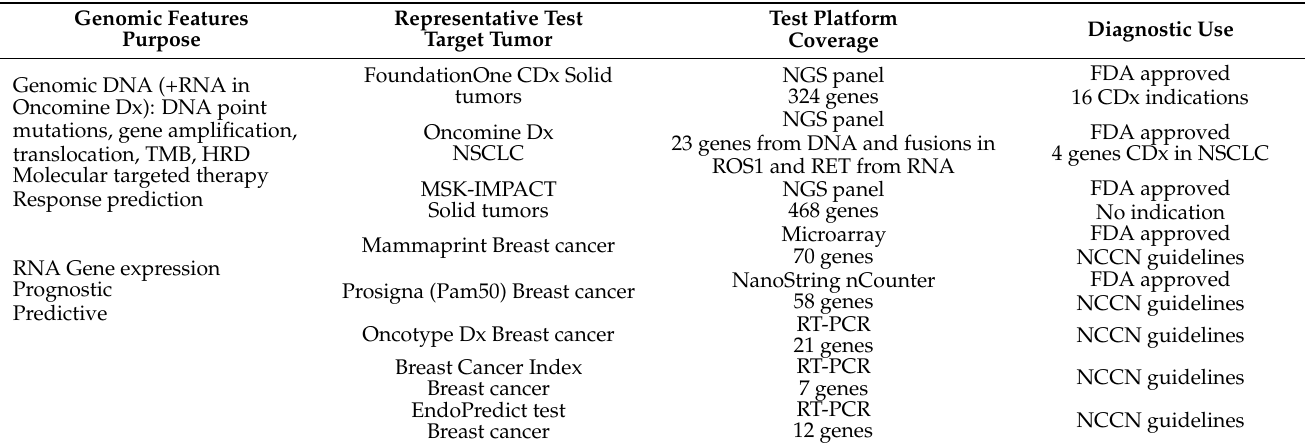
Table 1. Cancer genomics implemented in the clinical decision